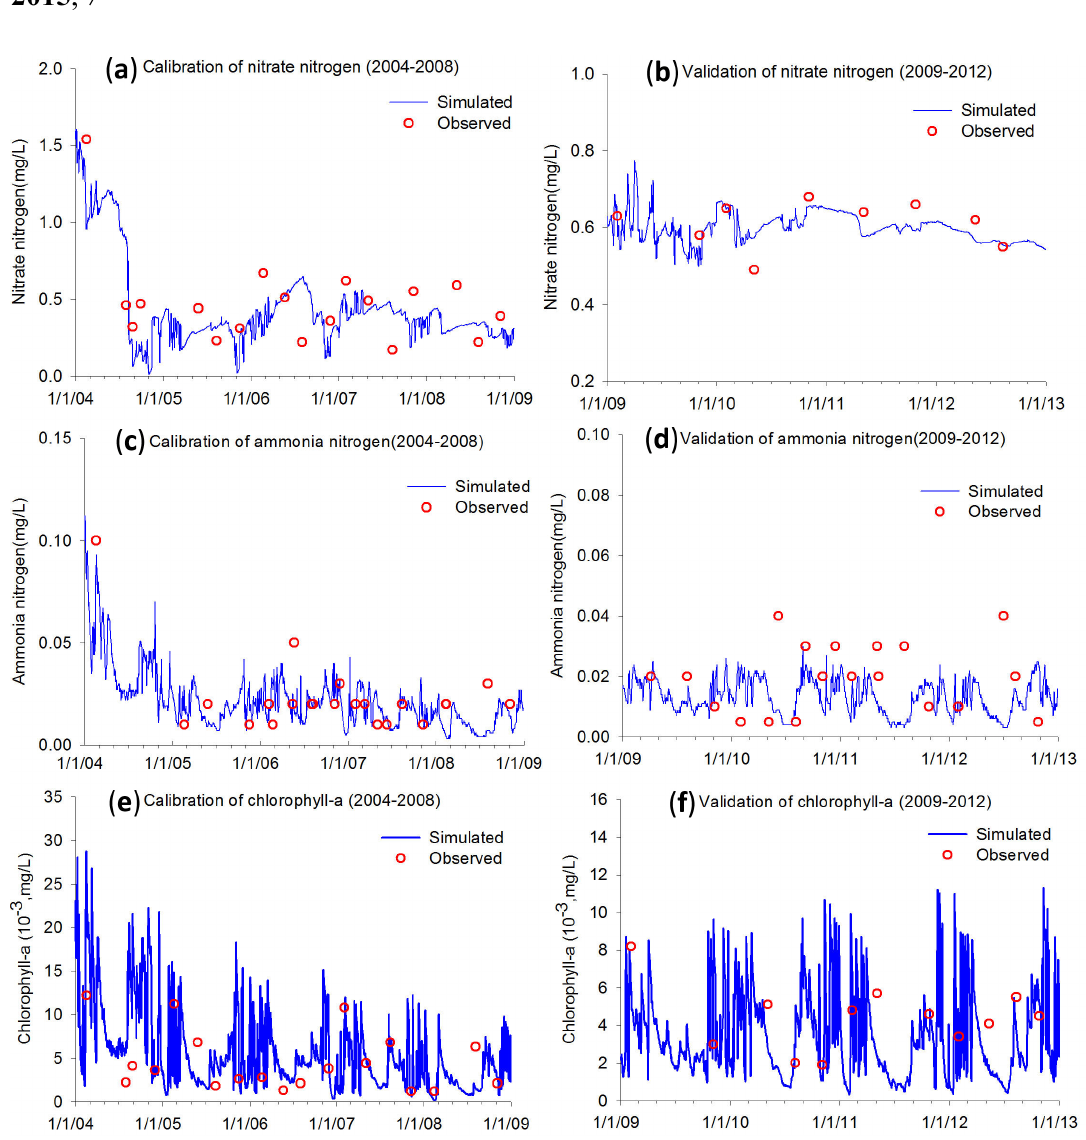
Figure 7. The calibration and validation results of W2 simulated water quality parameters at surface layer of segment 3. Sub-figures show the comparisons between W2 simulation results to: observed NO 3 –N concentrations during ( a ) calibration and ( b ) validation periods; observed NH 3 –N concentrations during ( c ) calibration and ( d ) validation periods; and observed Chl- a concentrations during ( e ) calibration and ( f ) validation